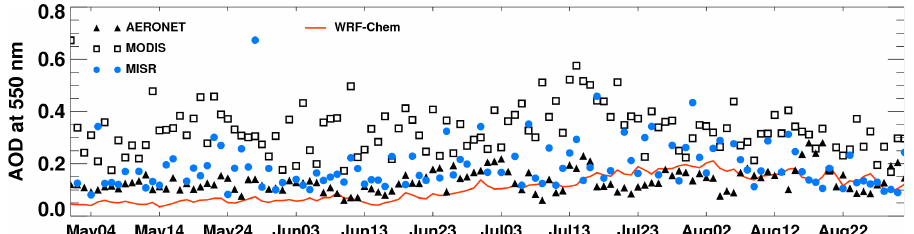
Fig. 4. Daily AOD from the measurements of AERONET, MODIS, and MISR and simulations by WRF-Chem at the AERONET site Figure 4 Daily AOD from the measurements of AERONET, MODIS, and MISR and 5 Maricopa (Fig. 2) for May–August, 2003–2009. simulations by WRF-Chem at the AERONET site Maricopa (Figure 2) for May-August, 6